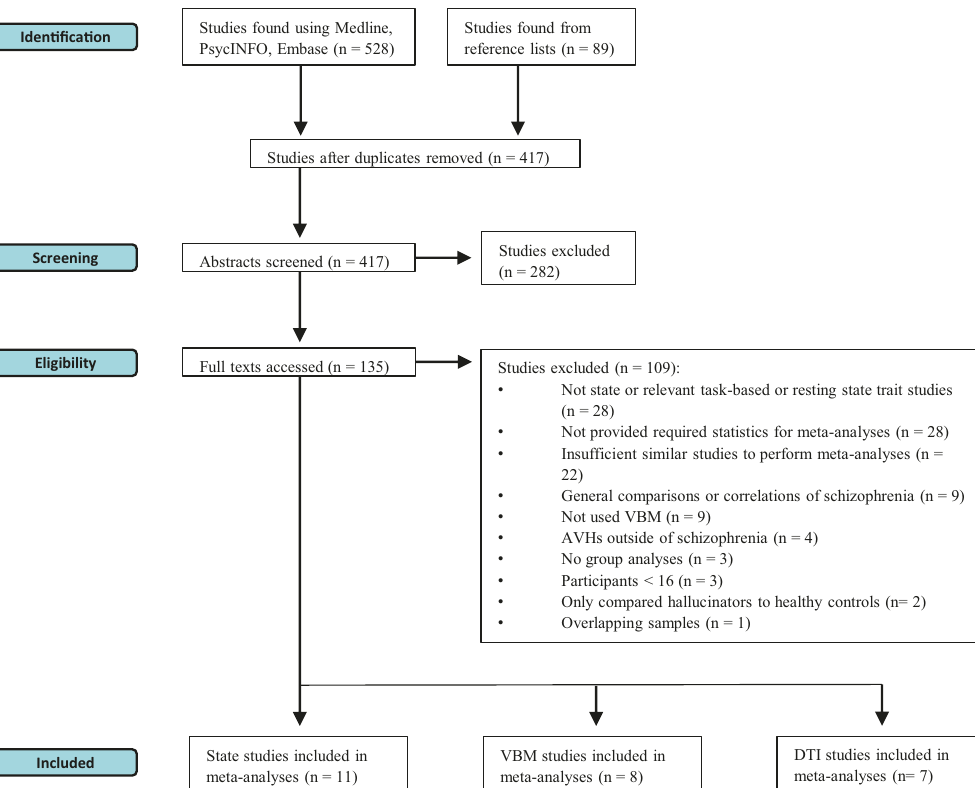
Fig. 1 A fl ow diagram illustrating the study selection process [51]. VBM voxel-based morphometry, AVHs auditory verbal hallucinations, DTI diffusion tensor